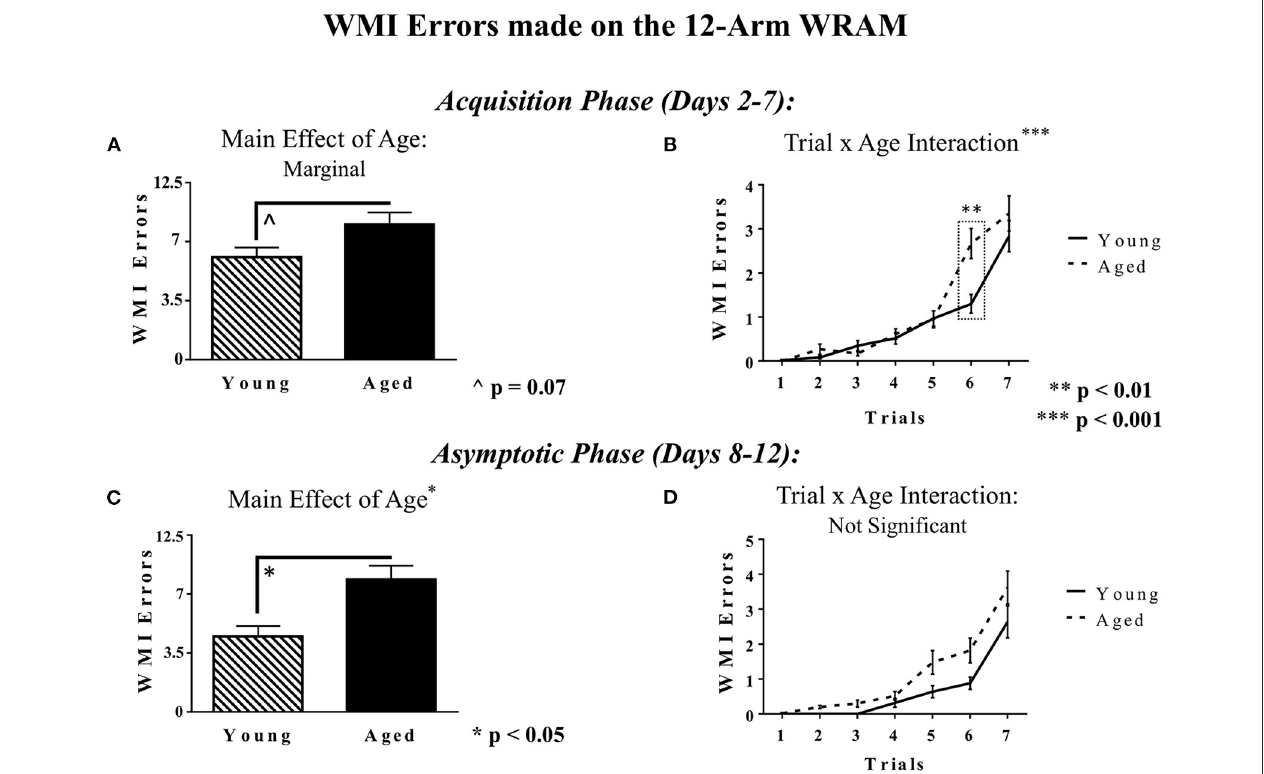
FIGURE 5 | WMI errors within the 12-Arm WRAM. (A) The marginal main effect of Age on WMI errors within the 12-Arm WRAM for the Acquisition Phase (Days 2–7), where aged rats made marginally more WMI errors than young rats. (B) WMI errors across Trials 1–7 for Acquisition Phase (Days 2–7) of testing. (C) The main effect of Age on WMI errors within the 12-Arm WRAM for the Asymptotic Phase of testing (Days 8–12), where aged rats made significantly more WMI errors than young rats. (D) WMI errors across Trials 1–7 for the Asymptotic Phase (Days 8–12) of testing. For the Acquisition Phase, age effects were particular to a high working memory load trial, whereas by the end of testing, in the Asymptotic Phase, the age effects were not